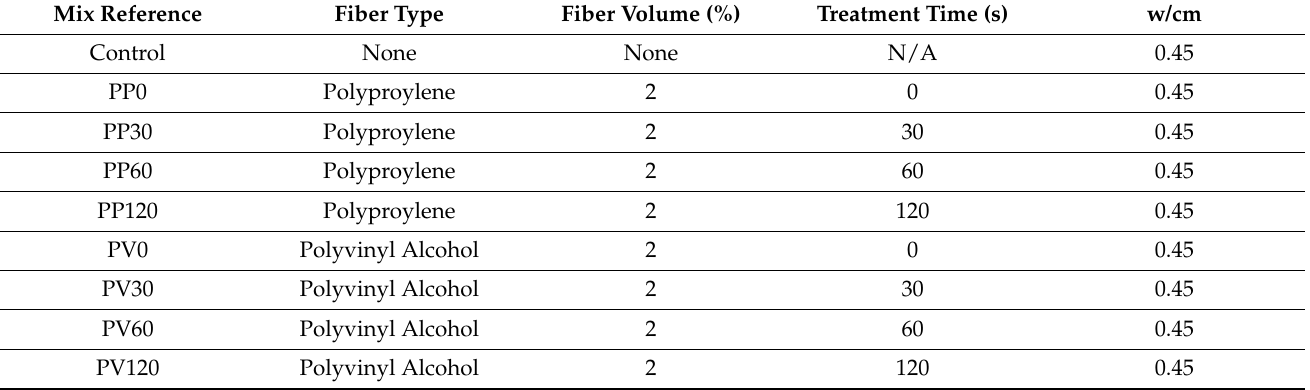
Table 2. Mixture